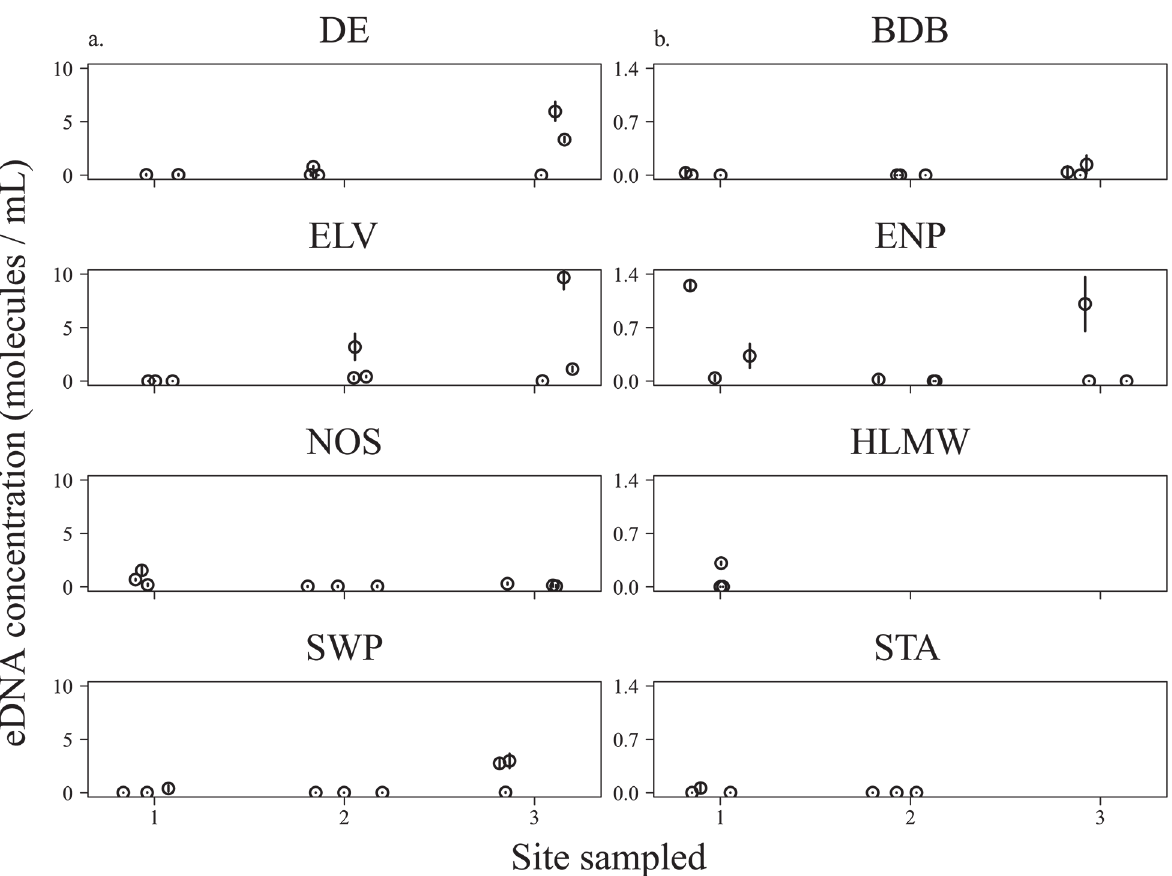
Fig 2. Estimated concentration of Burmese python environmental DNA (mean and 95% confidence interval) per sample. a. Higher concentration regions, y-axis scaled from 0 to 10 molecules/mL. b. Lower concentration regions, y-axis scaled from 0.0 to 1.4 molecules/mL. From each region, one to three locations were targeted, with triplicate field samples collected at each location. BDB, Bird Drive Basin; DE, Deering Estates; ENP, Everglades National Park; HLWM, Holey Lands Wildlife Management Area; SWP, Sweet Pea; NOS, Noosa; ELV, Elvis; STA, Stormwater Treatment Area 5.